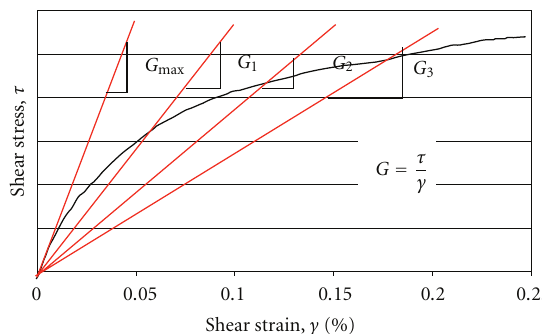
Figure 4: Change in shear moduli at di ff erent levels of shear strain [10, 11].